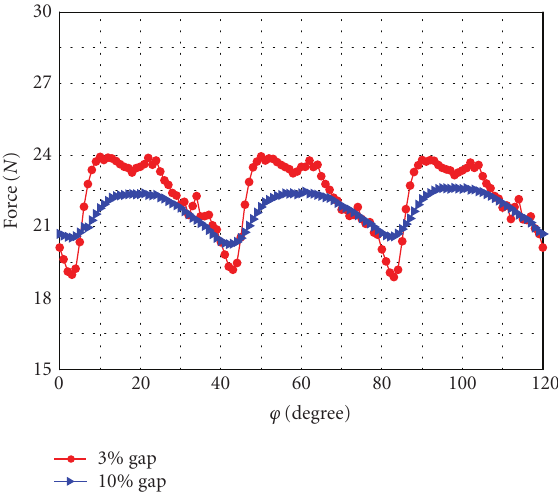
Figure 11: Total force on the impeller blade.